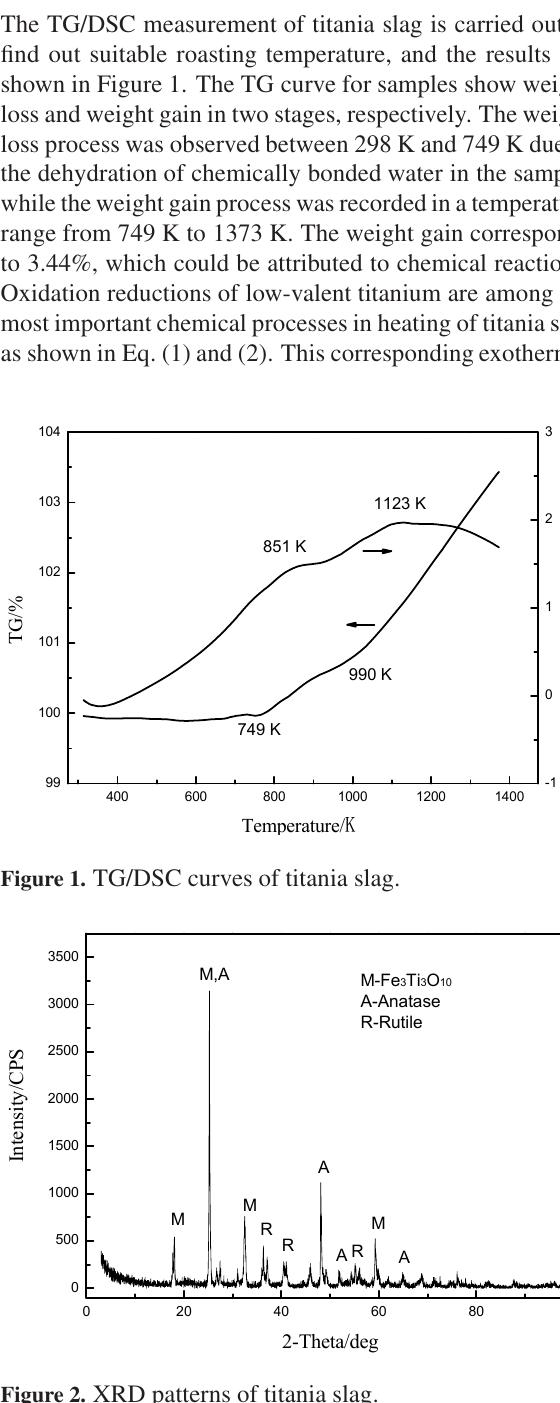
Figure 2. XRD patterns of titania